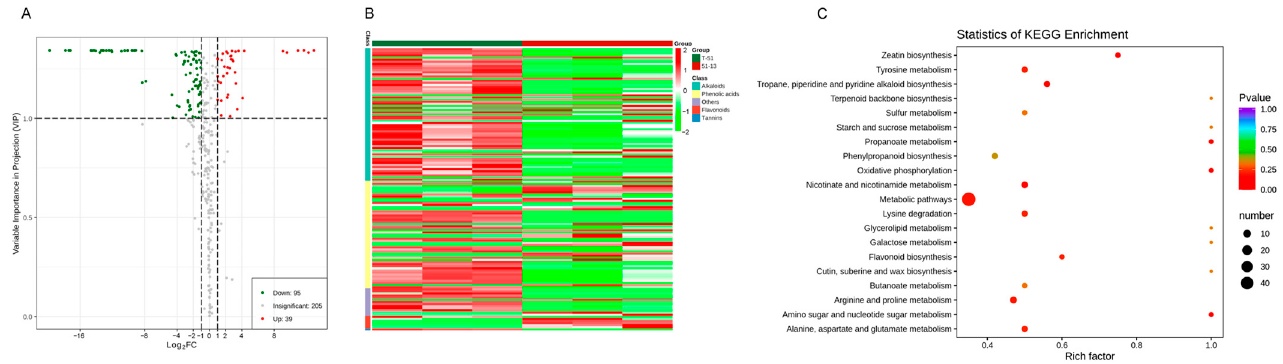
Figure 6. Metabolomic profiling of T-51 and 51-13. ( A ) Volcano plot of differential secondary metabolites (DSMs). Red and green dots represent the significantly up- and downregulated metabolites, respectively. ( B ) Heatmap of the DSMs based on hierarchical clustering analysis. ( C ) KEGG enrichment of the DSMs. Rich factor represents the ratio of the enriched DSMs to the total metabolites annotated in the corresponding pathway. Table 1. The compounds upregulated in the CF of 51-13 compared with that of